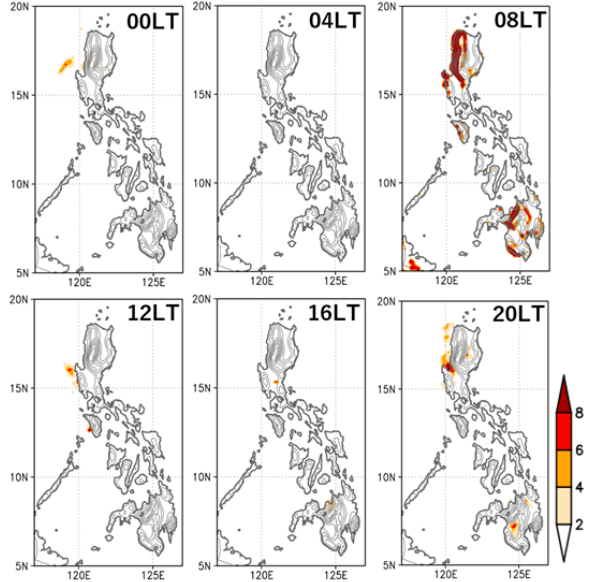
Figure 10. Spatial distribution of hourly frequency of the 0.1% most extreme ramp-down events at each grid point (shaded). The contours indicate terrain heights (100-m intervals).